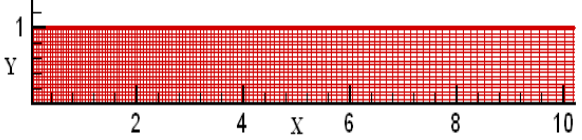
Fig. 2. Employed mesh geometry in the